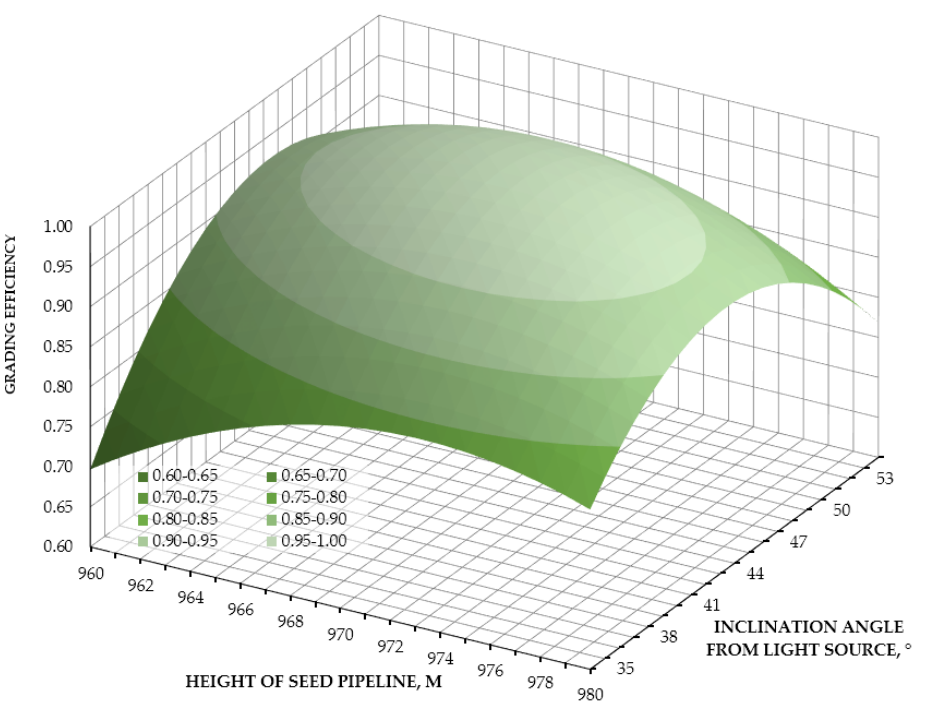
Figure 4. The response surface of the NIR grading efficiency determines the grader’s optimal engi- neering parameters when fixing the 0.2 m level for the seed pipeline height .